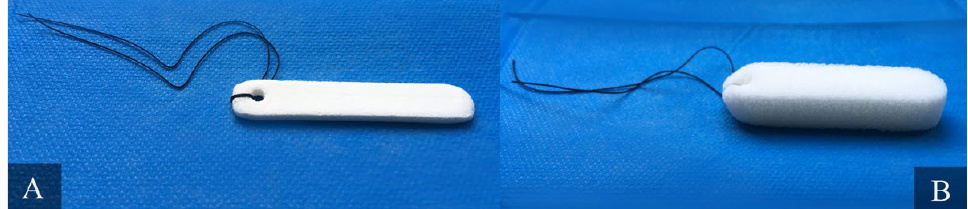
Figure 4. Nonabsorbable nasal packing Merocel (Medtronic Inc., Minneapolis, MN, USA). Panel ( A ) presents compressed, dehydrated sponge. Panel ( B ) shows the sponge decompressed, 30 s after hydration with saline. Material from the authors’ collection.